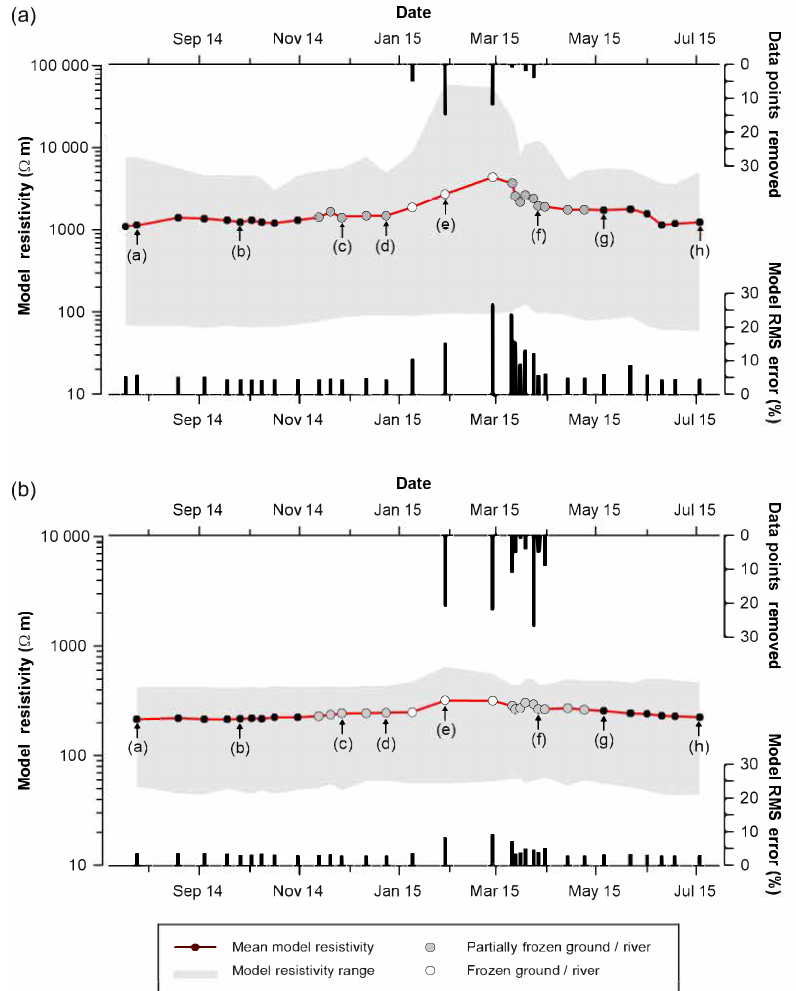
Figure 9. Temporal variations in inverted resistivity models for (a) pool and (b) riffle. Black dots represent unfrozen conditions and grey dots indicate partially frozen conditions, while white dots indicate completely frozen river conditions. Select resistivity models along the time series are shown in Fig.